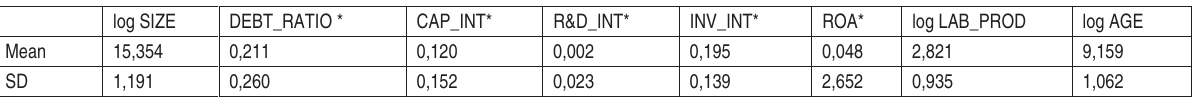
Table 3. Mean and standard deviation of the main independent variables used in the empirical analysis